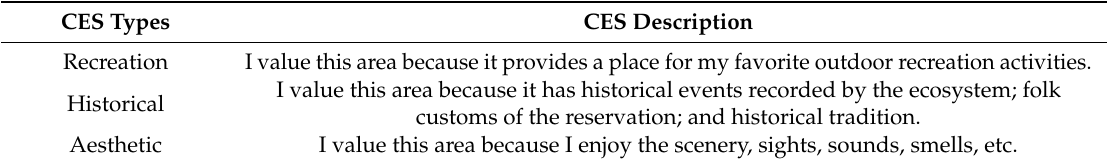
Table 2. The descriptions of cultural ecosystem services (CES)